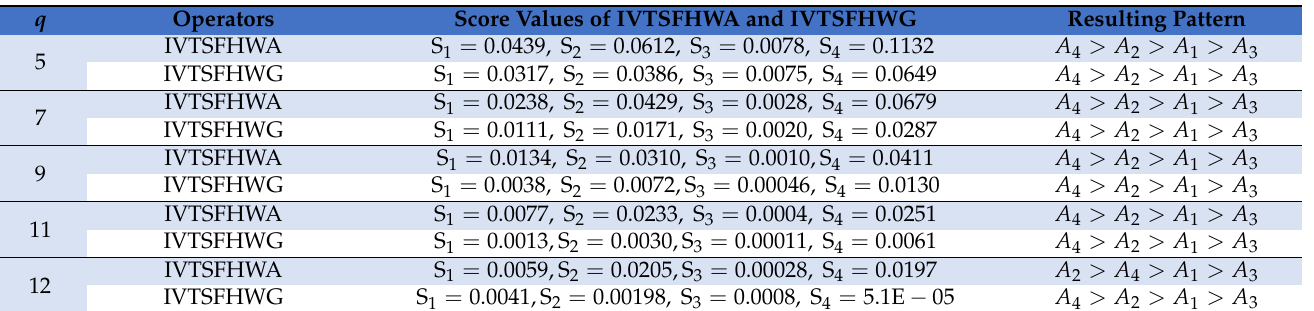
Table 5. Ranking result for various values of “ q ” when γ = 2.